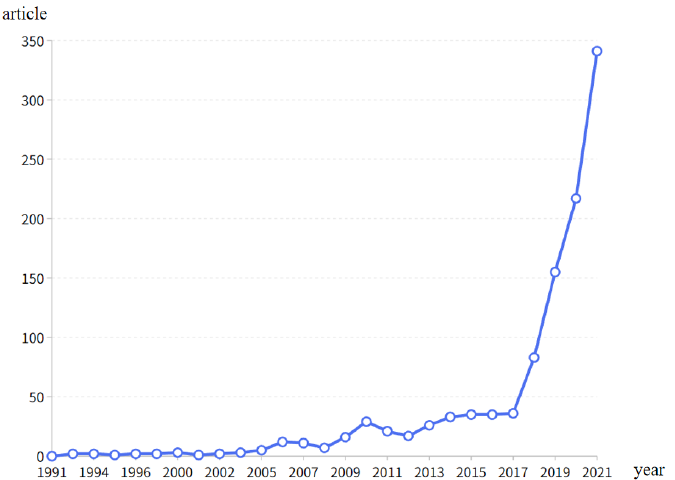
Figure 2. Annual scientific outputs in the field of rural revitalization from 1991 to